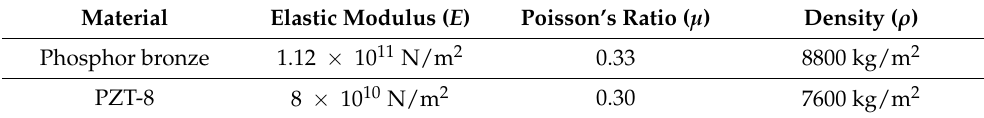
Table 2. Stator material parameters.